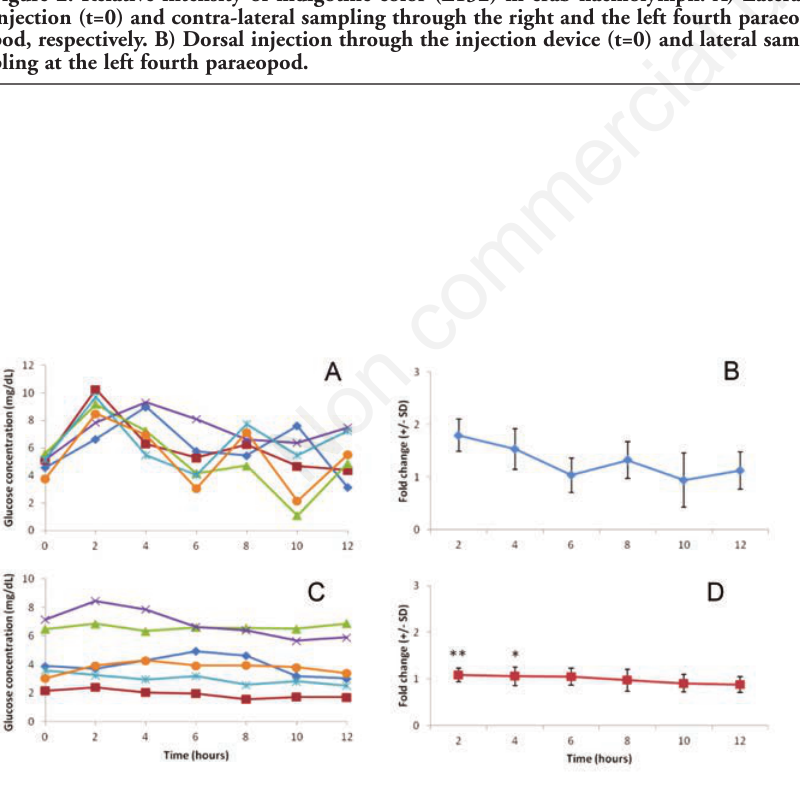
Figure 3. Variations of haemolymph glucose in crabs over a 12 h light cycle. A) Glucose levels of individual crabs after sampling via the fourth paraeopod; B) fold change in gly- caemia after sampling via the fourth paraeopod (n=6), means±SD; C) glucose levels of individual crabs after sampling via the injection device; D) fold change in glycaemia after sampling via the injection device (n=6), means±SD. Significance compared with control determined by t-test *P<0.05,